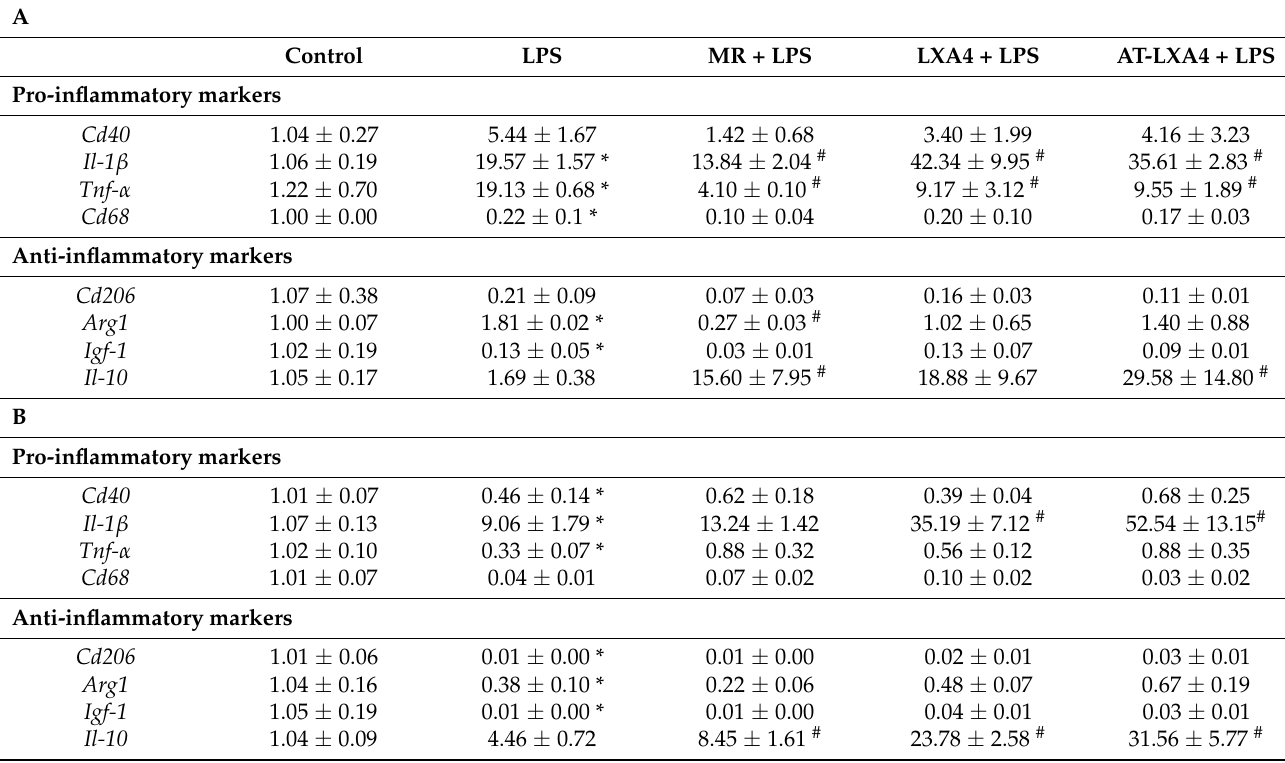
Table 1. The time-dependent effect of 3 h ( A ) and 24 h ( B) of lipopolysaccharide stimulation and FPR2 ligands: MR-39, LX- A4, or AT-LXA4 treatment on the gene expression of pro-inflammatory ( Cd40 , Il-1 β , Tnf- α , and Cd68) and anti-inflammatory ( Cd206 , Arg1 , Igf-1 , and Il-10 ) microglia markers. Control cultures were treated with the appropriate vehicle. The mRNA levels were measured using qRT-PCR from independent experiments; n = 2–4 in respective experiments. The results are presented as the average fold change ± SEM. * p < 0.05 vs. control, # p < 0.05 vs. LPS